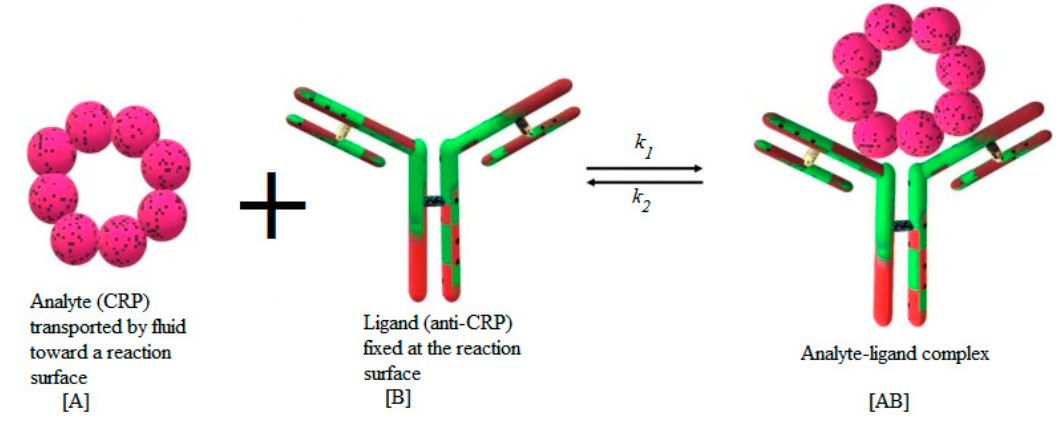
Figure 2. Schematic illustration of C-reactive protein (CRP) binding reaction.